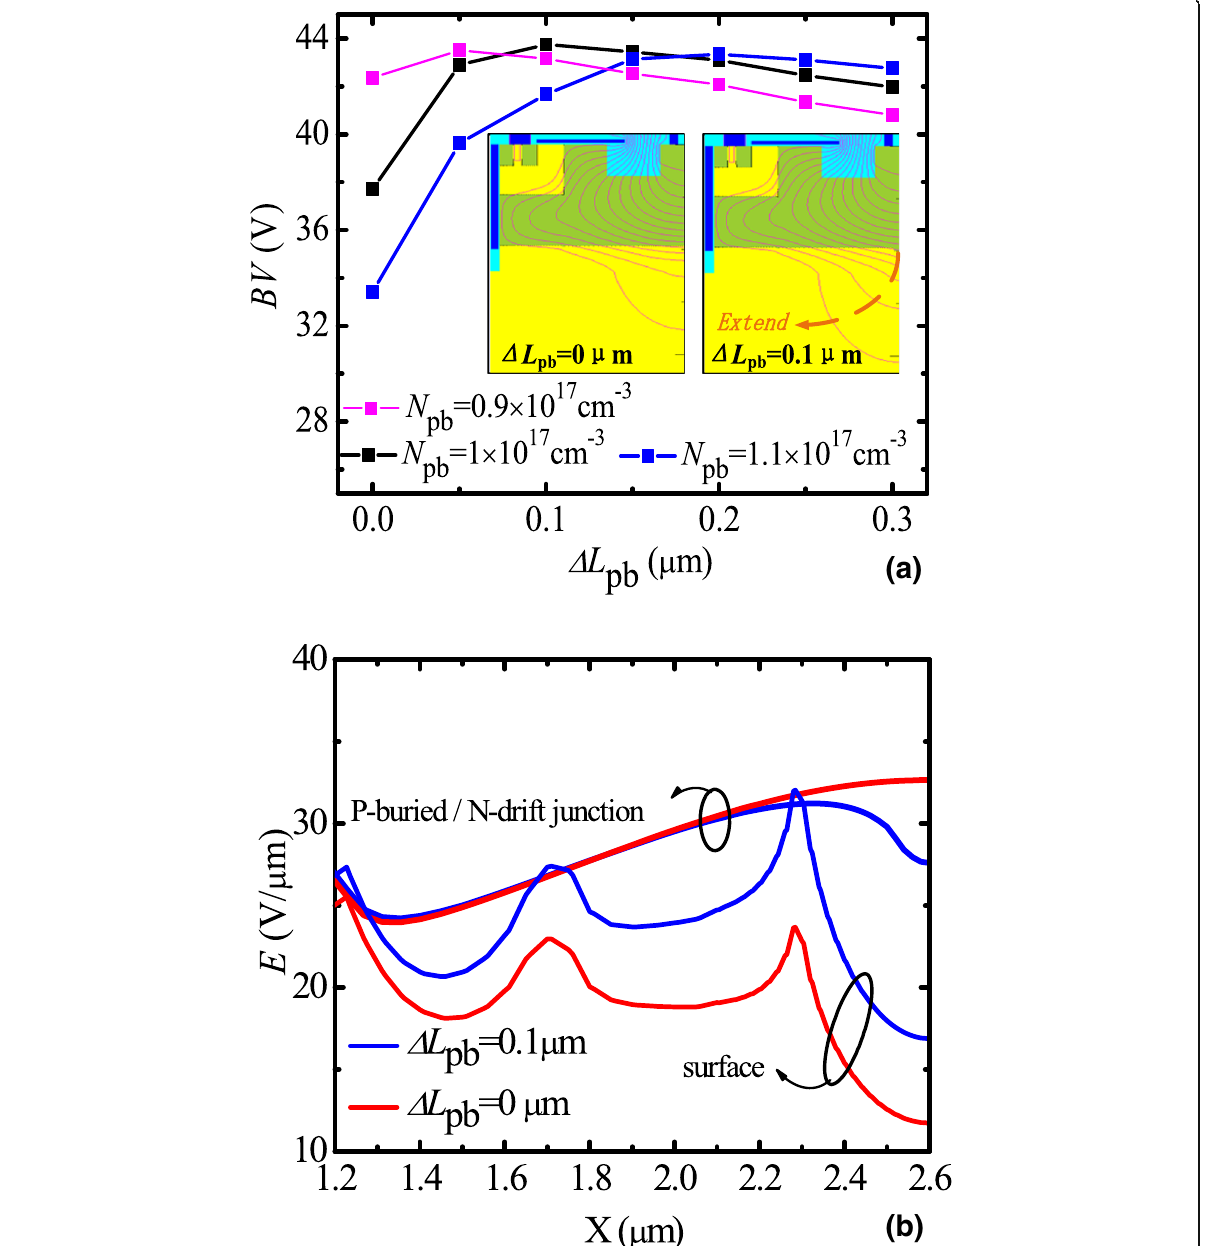
Fig. 4 a BV as a function of Δ L pb with different N pb . The insert is the equipotential contour profile with N pb = 1 × 10 17 cm − 3 . b Electric